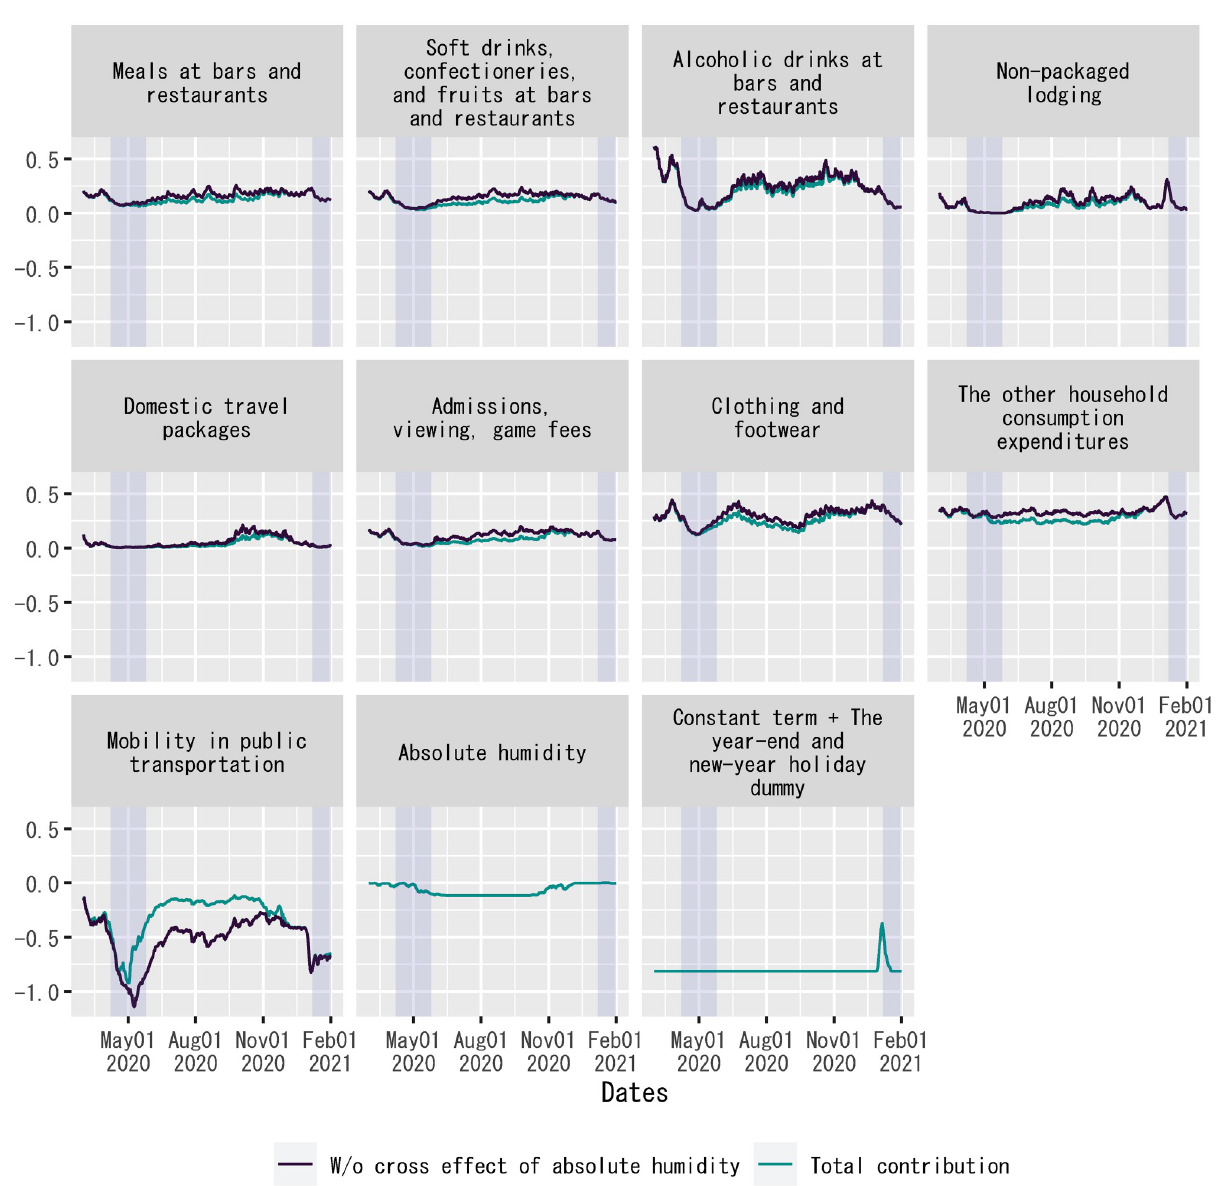
Fig 9. Decomposition of fitted values of the regression: Level. Each panel shows the product of an explanatory variable and the posterior mean of the corresponding regression coefficient, when time dummies for the period before the first state of emergency, the first state of emergency, and the second state of emergency are set to zero without changing the posterior means of regression coefficients. The sample period shown in the figure is from March 1, 2020, to February 1, 2021. For household expenditures and mobility in public transportation, “W/o cross effect of absolute humidity” indicates the posterior mean of γ ( X ) in Eq (7), whereas “Total contribution” indicates the posterior mean of γ j F j , t shadowed period indicates a state of emergency.